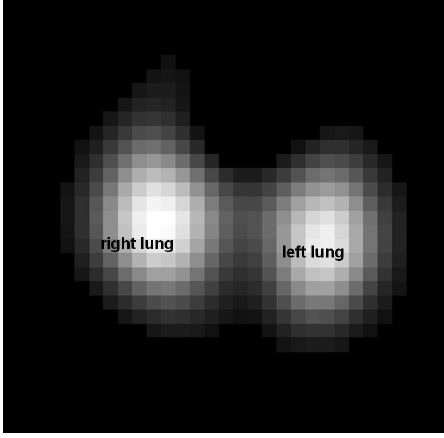
Figure 2 - Lung perfusion reference image, obtained by hypertonic saline